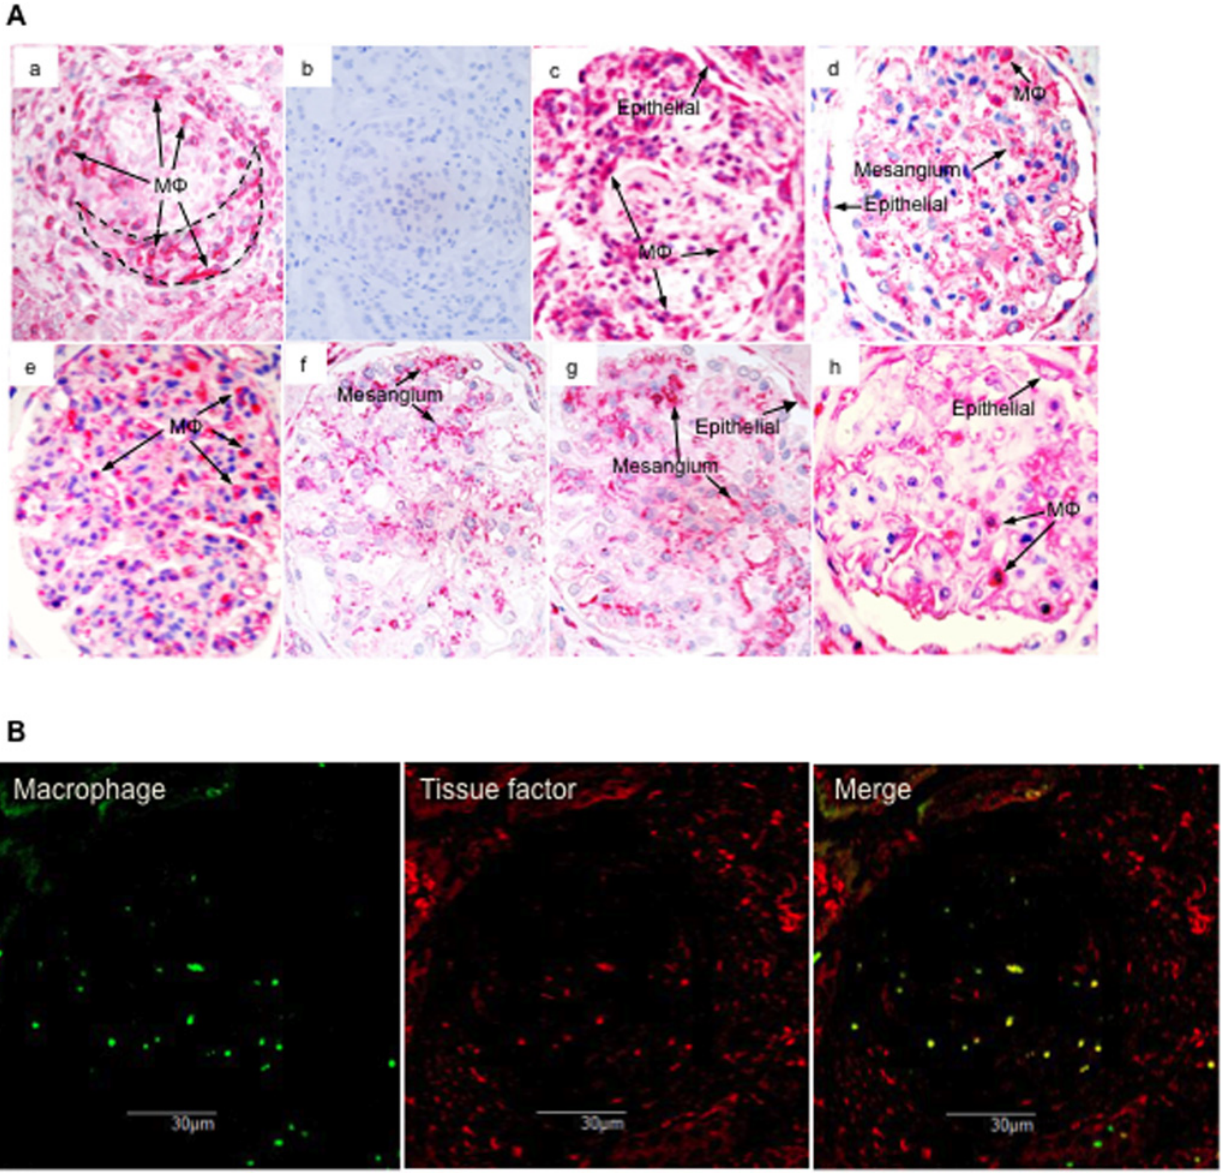
Fig 2. Glomerular tissue factor expression in biopsy tissues. ( A ) Representative tissue factor expression patterns of renal biopsy tissues as shown by immunostaining. All patients, except those with acute glomerulonephritis (AGN), had thrombinuria. ( a ) Crescentic glomerulonephritis (CresGN); ( b ) control staining of CresGN with normal mouse IgG; ( c ) membranoproliferative glomerulonephritis; ( d ) IgA nephropathy; ( e ) AGN; ( f ) minimal change glomerulopathy; ( g ) focal segmental glomerulosclerosis; and ( h ) membranous nephropathy. M φ indicates monocytes/macrophages; Epithelial, epithelial cells; and Mesangium, mesangial areas. The broken line in ( a ) outlines a cellular crescent. ( B ) Double-staining pattern of CD68 (macrophages) and tissue factor in the CresGN glomerulus.